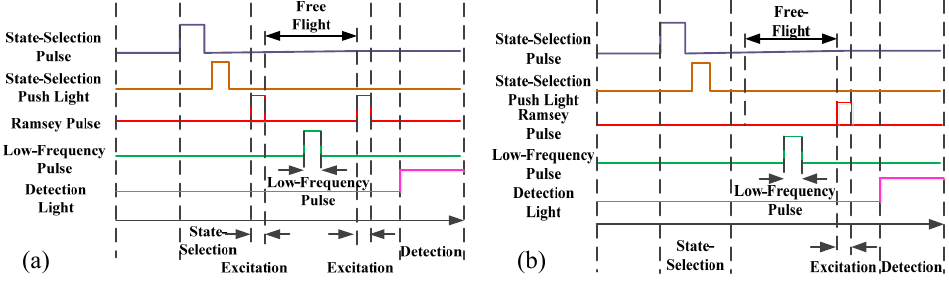
Figure 4. Relevant time sequence diagram of the experiment; ( a ) time sequence for the measurement of atomic flight region; ( b ) time sequence for the measurement of Ramsey cavity.